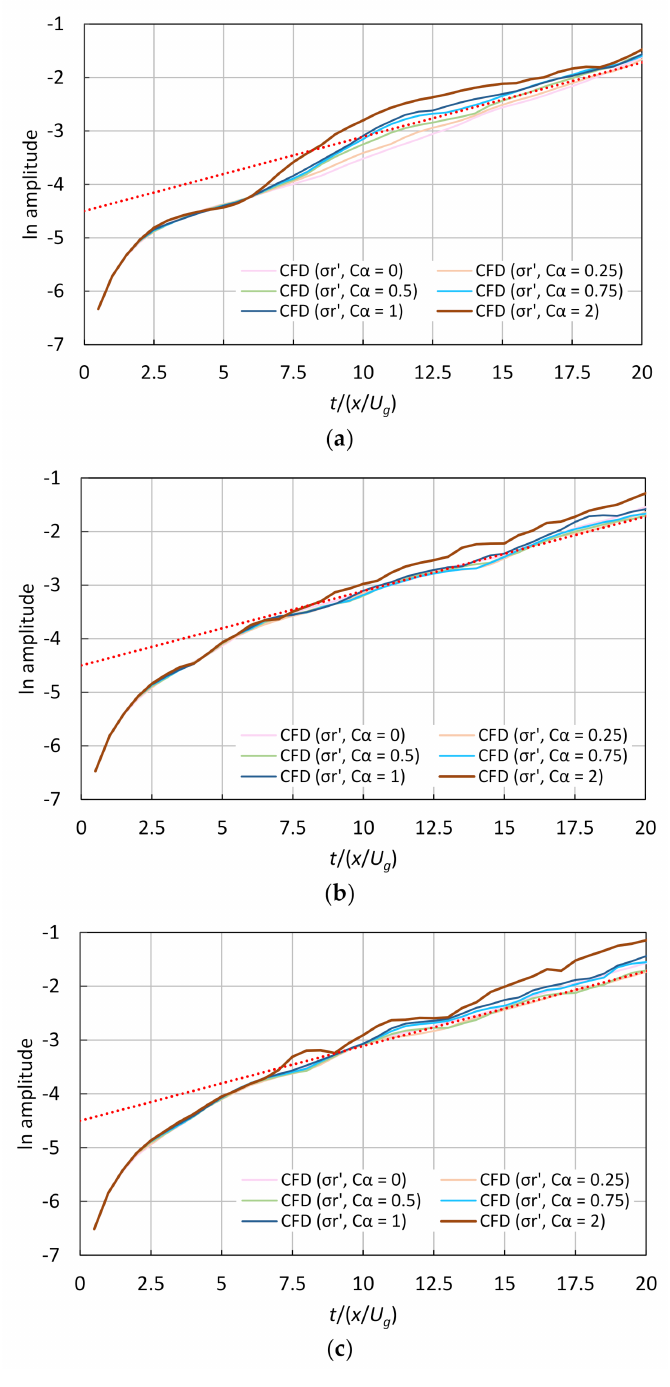
Figure 10. Time variation of the natural logarithm of the disturbance amplitude for different interface compression (IC) coefficients ( C α ), at We g = 2: ( a ) 0.5 cells/ A c , ( b ) 1.5 cells/ A c , and ( c ) 2.5 cells/ A c